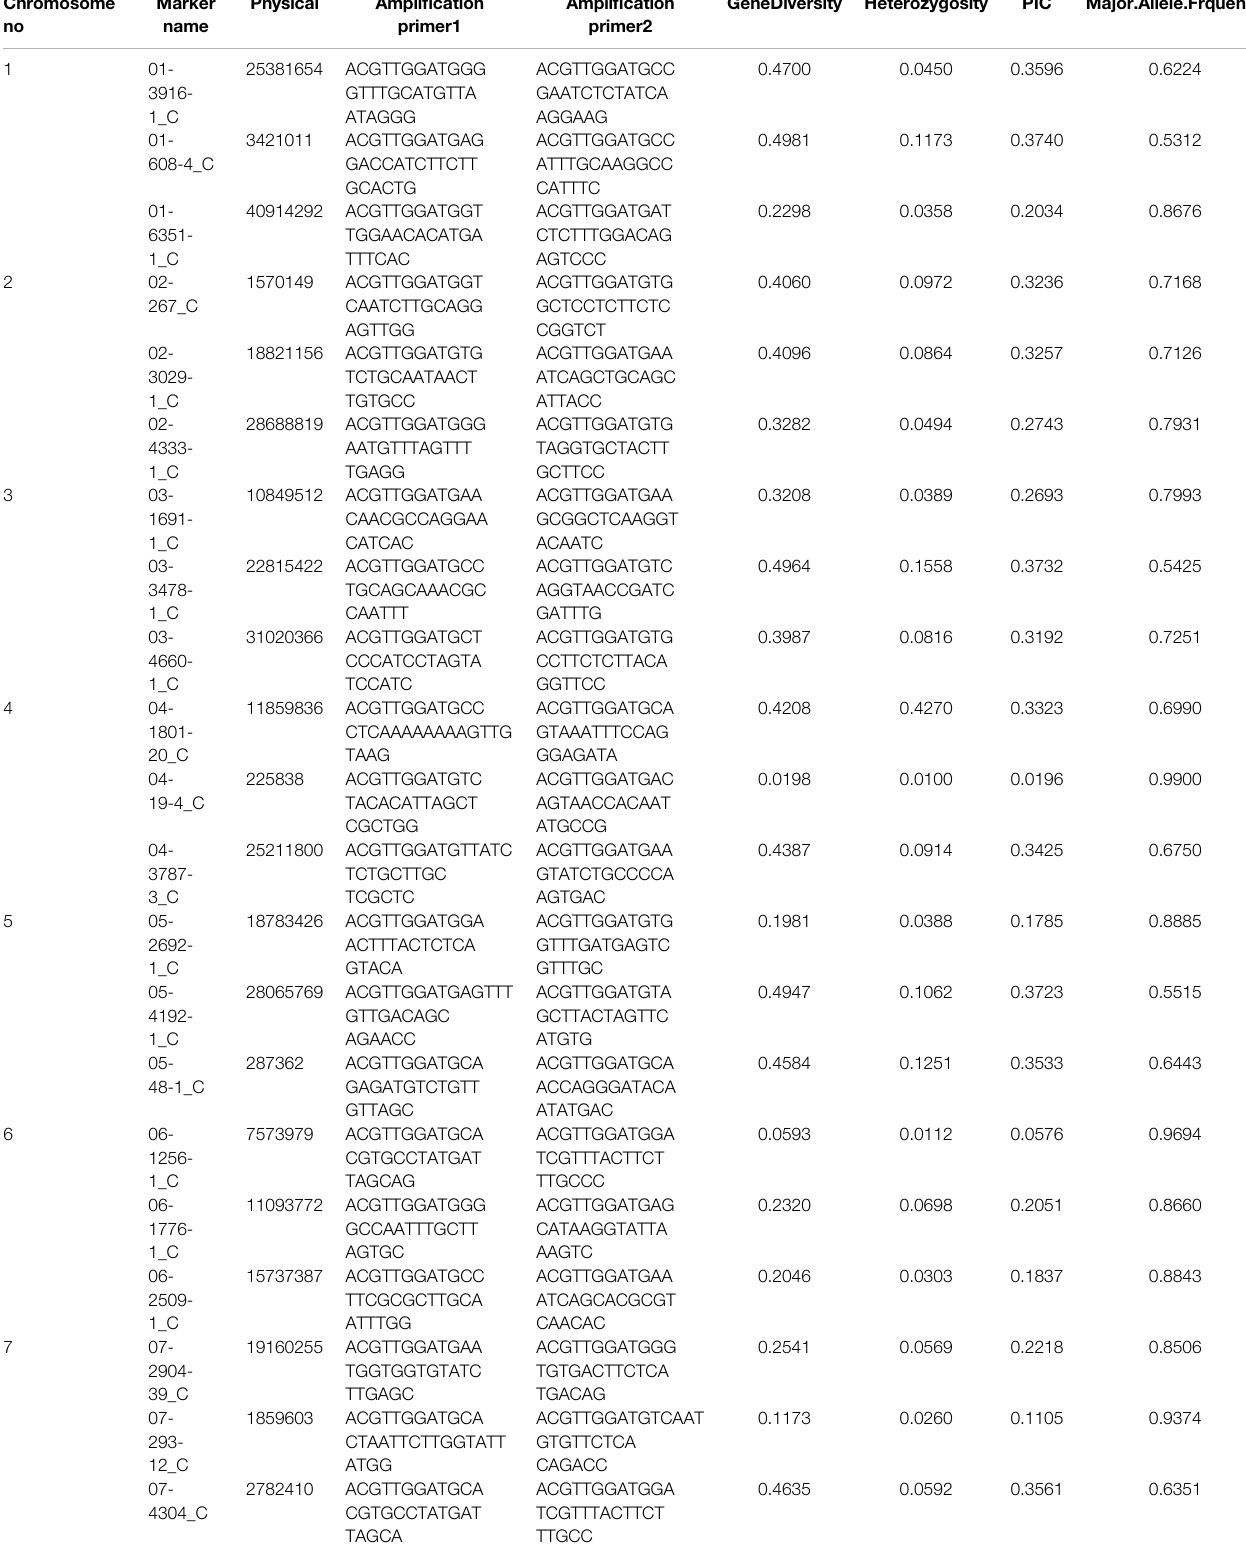
TABLE 1 | List of SNP primers used for genotyping of 2,242 rice accessions along with gene diversity, heterozygosity, PIC, and major allele frequency. Chromosome